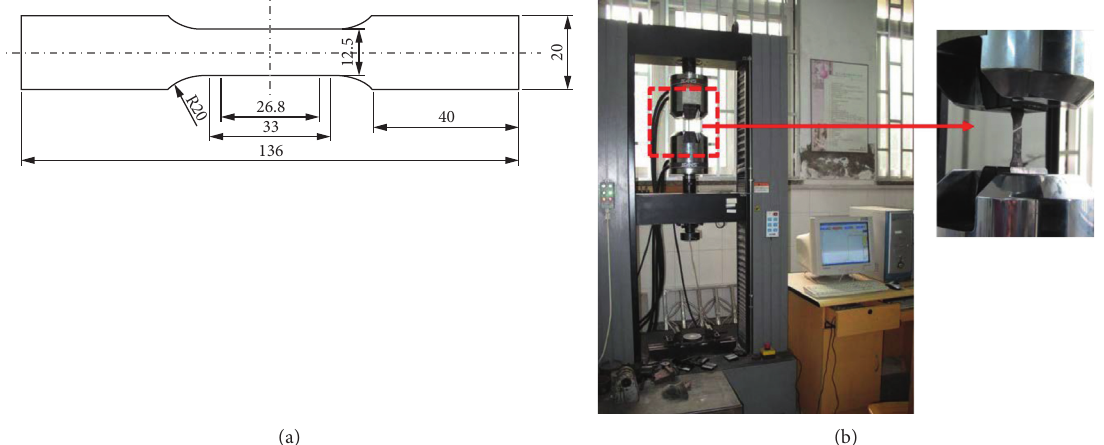
Figure 2: Specimen of the tensile test: (a) specimen size and (b) tensile device.